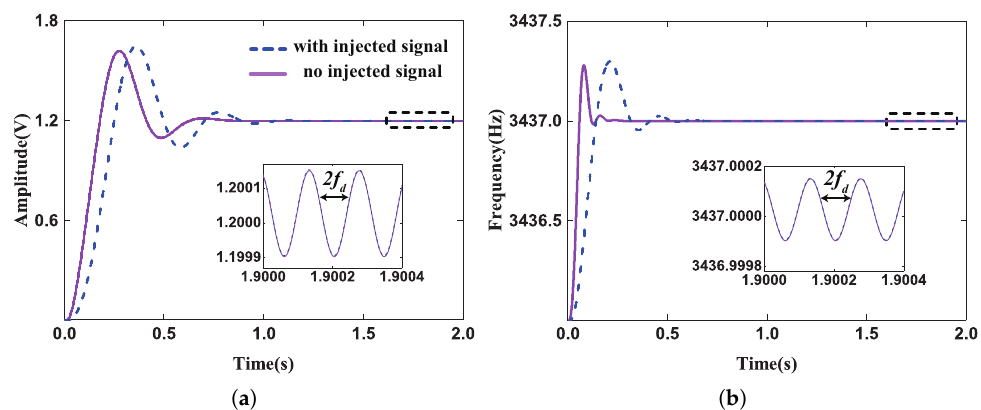
Figure 8. ( a ) The simulation for the amplitude of driving control signal. ( b ) The simulation for the frequency of driving control signal.